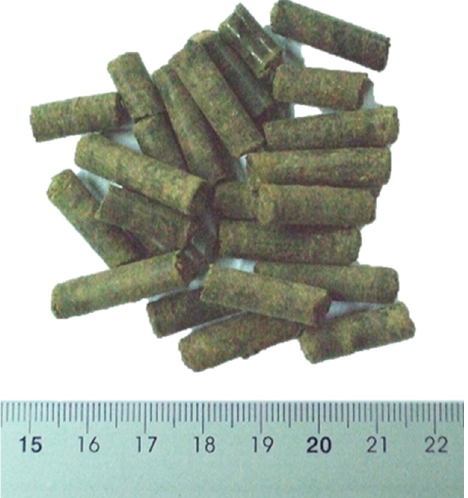
Figure 3. Pellets from the P2